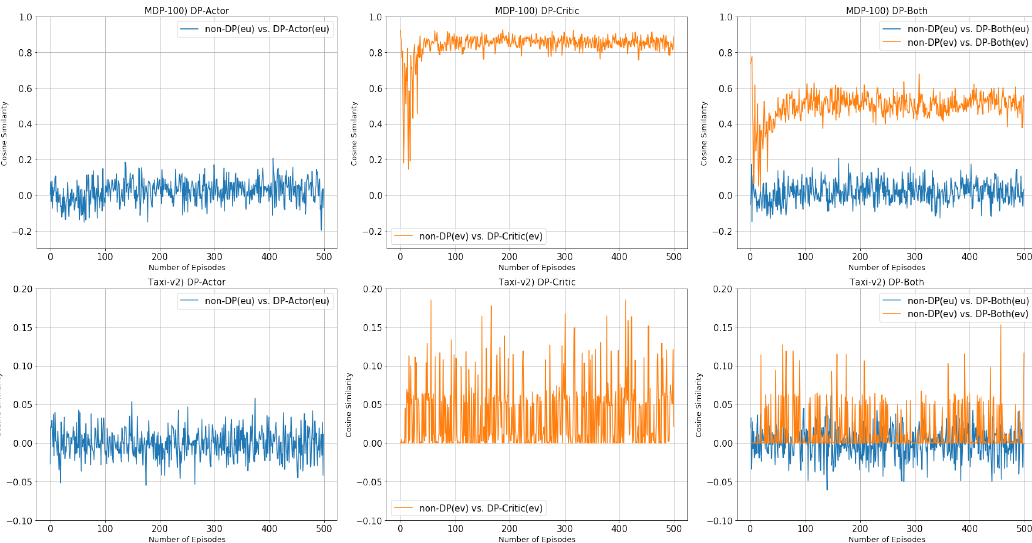
Figure 4. Cosine similarities of eligibility trace vectors between the vectors from non-DP ( e u , e v ) and corresponding vectors from each cases (DP-Actor ( e u ), DP-Critic ( e v ), and DP-Both ( e u , e v )). We averaged the vectors generated from same episode over 10 runs to avoid random seed